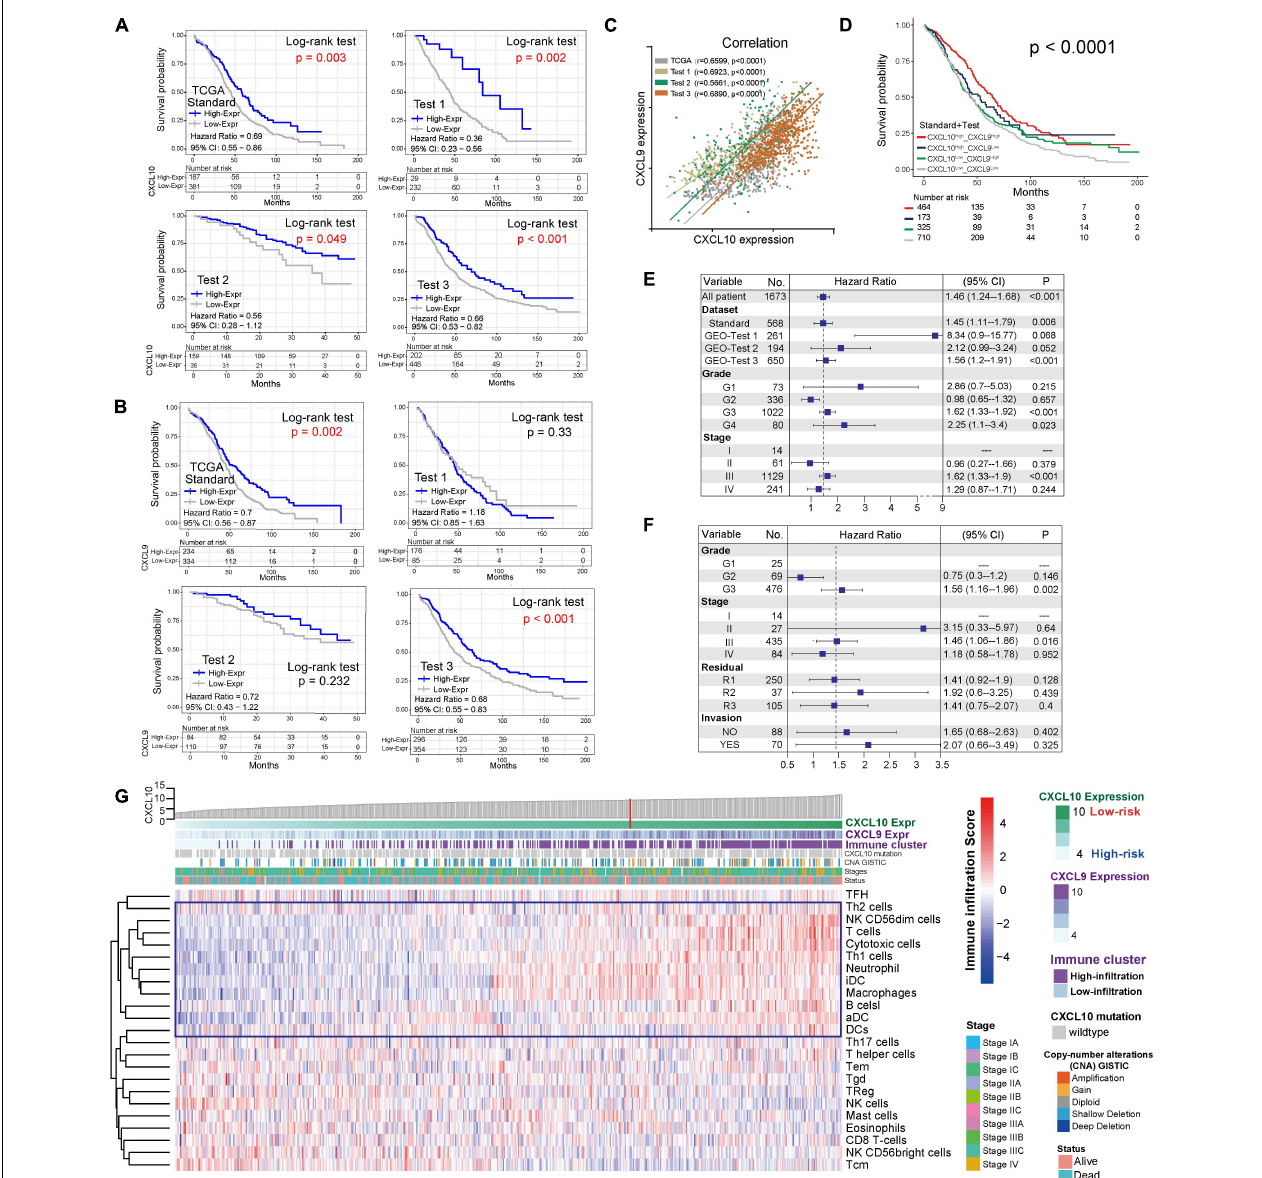
FIGURE 1 | Landscape of the CXCL10 and CXCL9 expression and TME cells-infiltration in ovarian cancer. (A) Kaplan-Meier survival analysis of CXCL10 expression in four independent cohorts of ovarian cancer. Patients were stratified into low- (blue; CXCL10 high expression) and high- risk (gray; CXCL10 low expression) classifications with a cutoff value of OS by survminer. Log-rank P < 0.05 showed a significant survival difference. (B) Kaplan-Meier survival analysis of CXCL9 expression in four independent cohorts of ovarian cancer. (C) Correlation analysis between CXCL10 and CXCL9 expression in four independent cohort. The r values were verified by the Pearson test ( P < 0.0001). (D) Survival analyses for subgroup patients stratified by both CXCL10 and CXCL9 expression with Kaplan-Meier curves ( P < 0.0001, Log-rank test). (E) Forest plot representation of the clinical prognostic value between high/low risk classification in independent cohorts and clinical parameters. Hazard ratios (HR) > 1.0 indicated that CXCL10 expression is a favorable prognostic biomarker. (F) Subgroup analyses estimated prognostic value of tumor pathology in standard cohort. (G) Heat map showed the scoring of TME immune cell infiltration in the standard cohort according to CXCL10 and CXCL9 expression subgroups. The thick line represented the unsupervised clustering of positive correlation. The risk classifications, immune cluster subgroups, Copy-number alteration (CNA), survival status and stages were used as patient